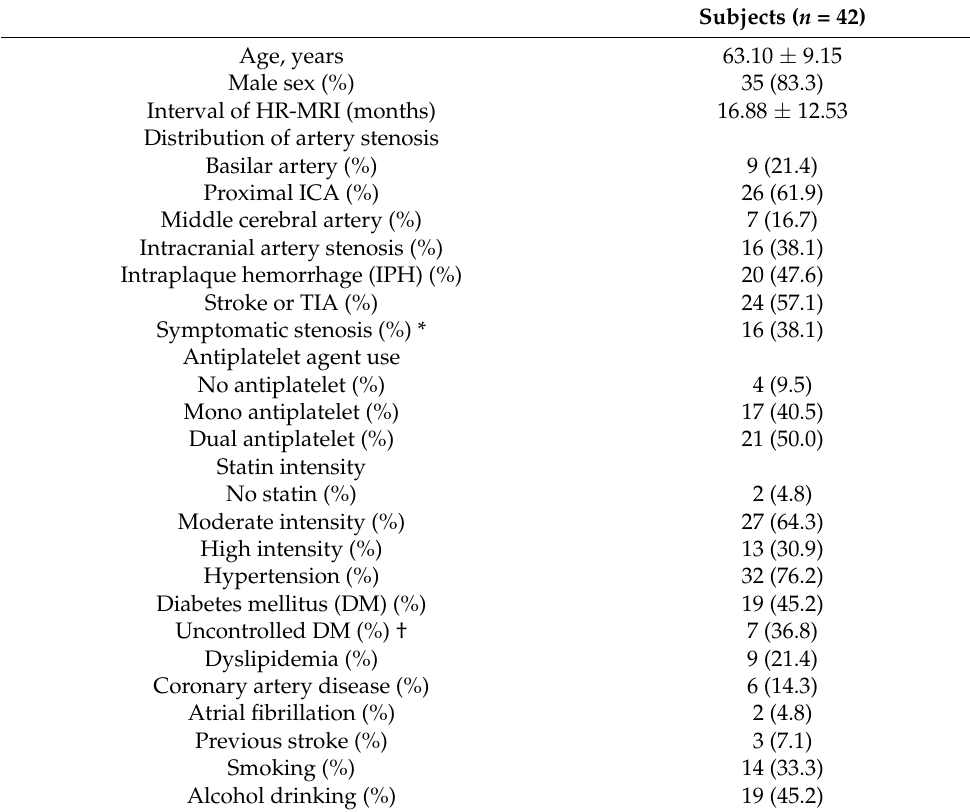
Table 1. Clinical characteristics of the